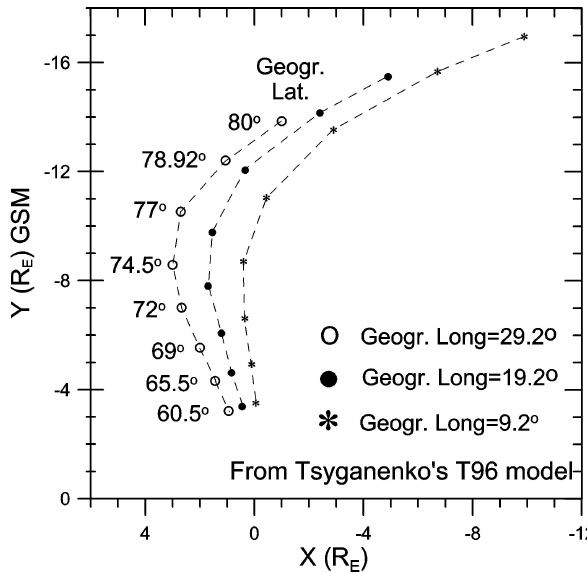
Fig. 11. Three hypothetic chains of ground stations with constant longitudes (i.e. 9.2, 19.2 and 29.2 ◦ ) are traced out along the mag- netic field lines via the T96 model and their conjugate points over the XY GSM plane are determined, for the conditions of the event which occurred on day 181,